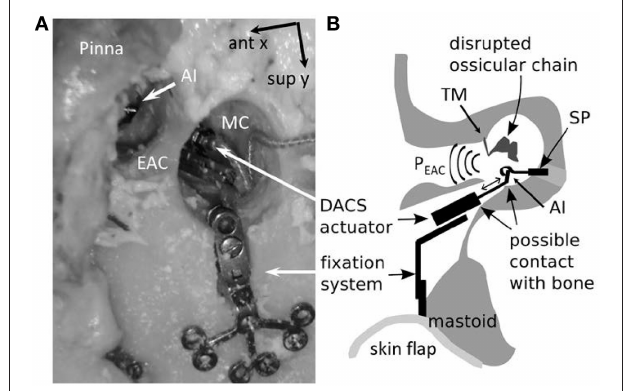
FIGURE 1 | Intraoperative representation of the DACS (Direct acoustic cochlear stimulation) as photograph in a human cadaver (A) and in a schematic drawing (B) . The pinna is flapped and a cavity in the mastoid (MC) is performed behind the external auditory canal (EAC) in order to position the fixation system and the DACS actuator. The tympanic membrane (TM) is elevated and ossicular chain interrupted. A piston prosthesis (SP) crimped on the artificial incus (AI) of the DACS transmits the vibrations to the inner ear. The sound emission of the DACS P EAC is propagated directly through the middle ear cavity to the EAC. Misplacement may happen most frequently in the narrow space of the facial recess leading to contact to the surrounding bone (indicated with arrows). ant x: anterior direction is defined as x-axis, sup y: superior direction is defined as